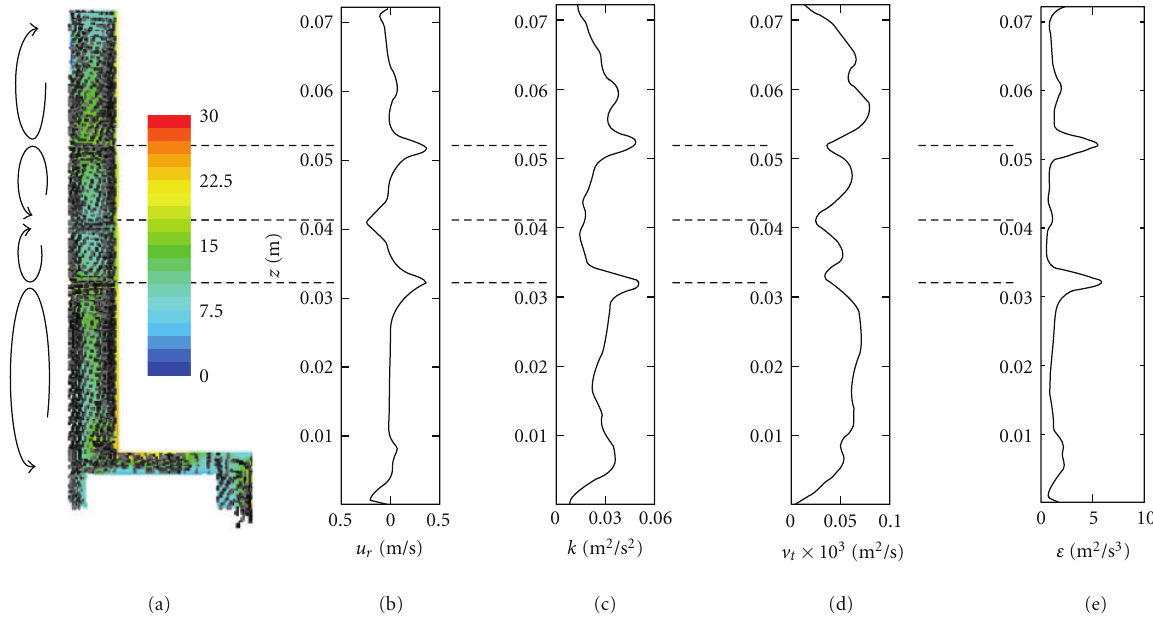
Figure 5: Flow patterns and turbulent properties at 30 r/s and total flow rate 4.16 mL/s at the center of annulus: (a) contours of turbulent intensities (%); (b) radial velocity profile; (c) turbulent kinetic energy profile; (d) turbulent viscosity profile; (e) turbulent kinetic energy dissipation profile [119].